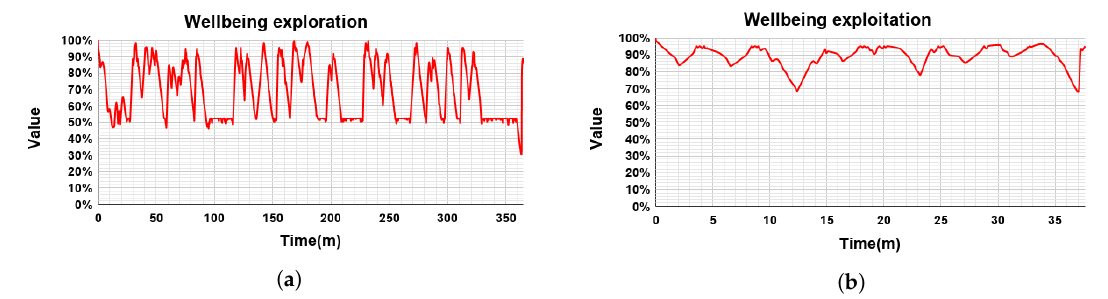
Figure 9. Evolution of Mini’s wellbeing during the evaluation. ( a ) Wellbeing of the robot during the exploration phase; ( b ) Wellbeing of the robot during the exploitation